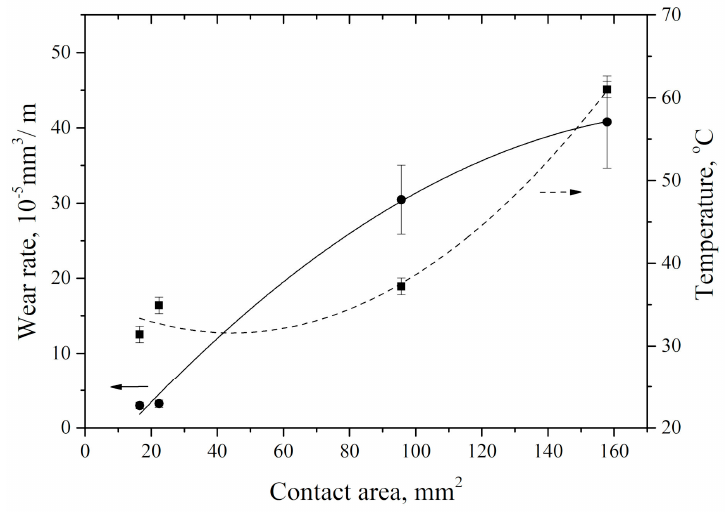
Figure 12. Counterpart temperature and wear rate vs. wear track area.